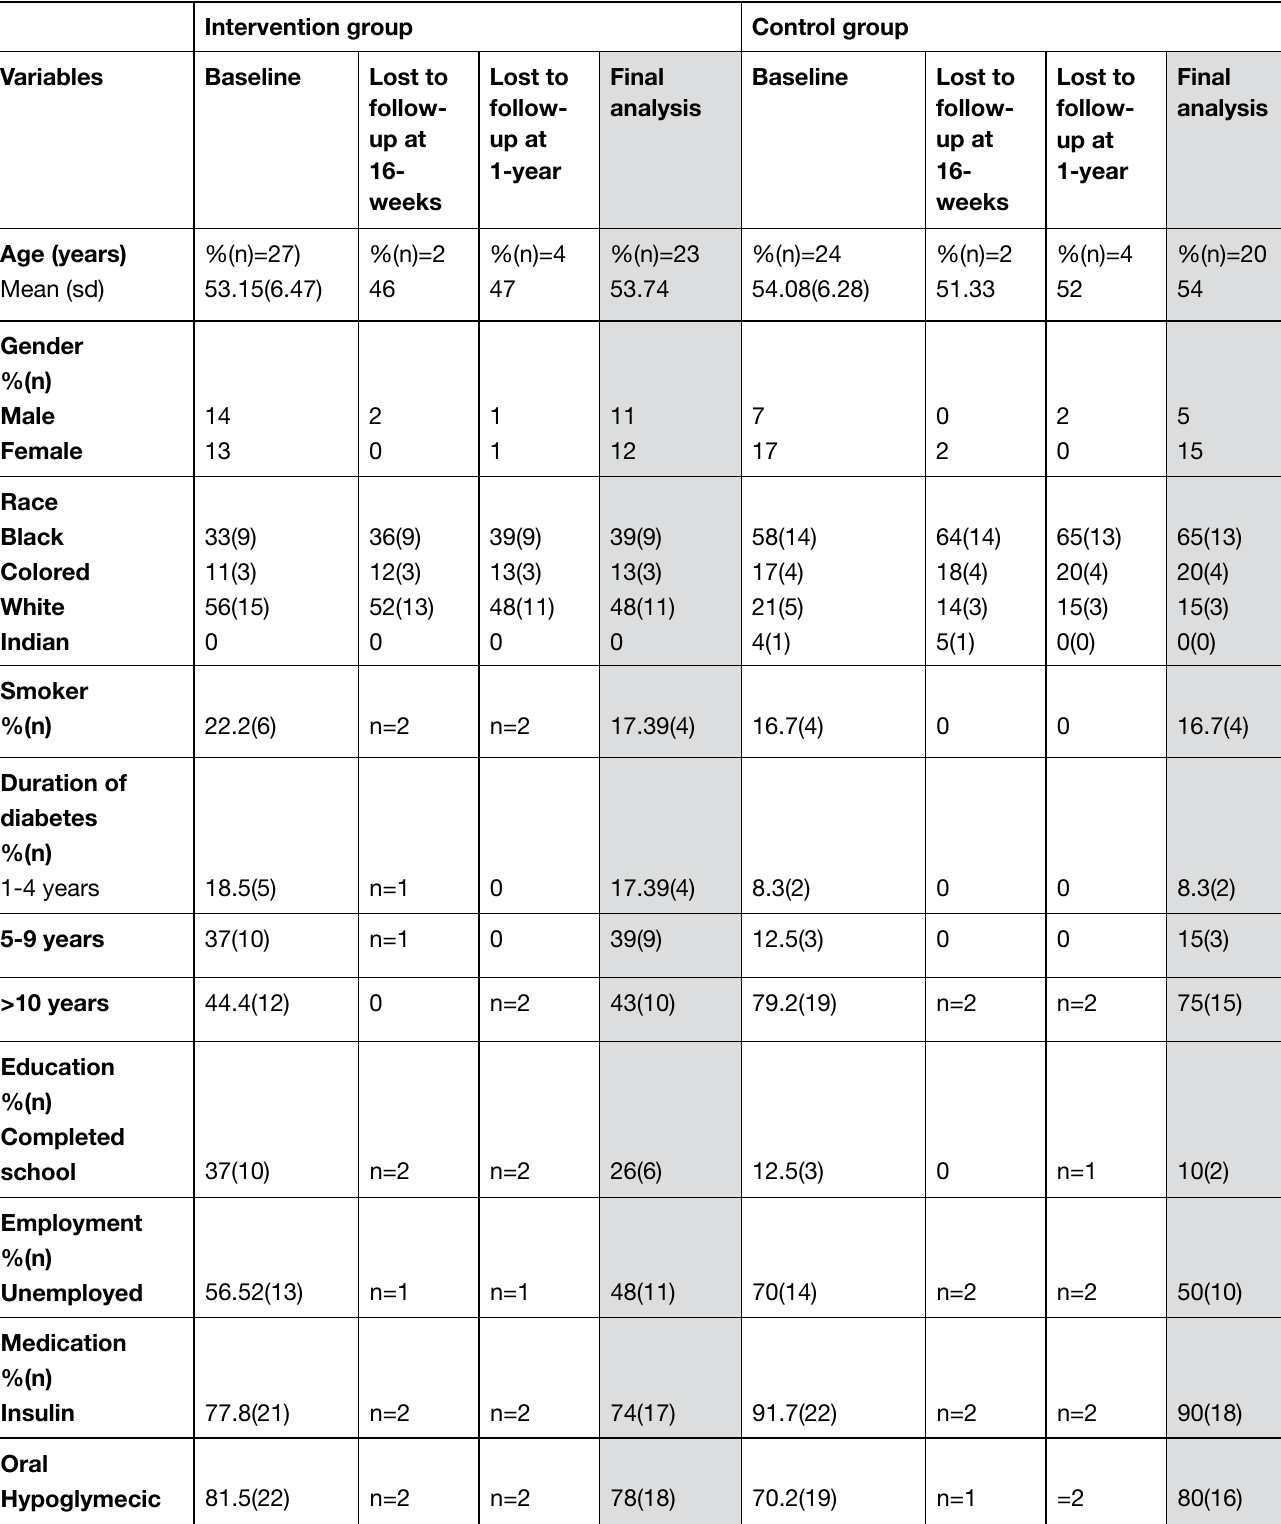
intervention group control